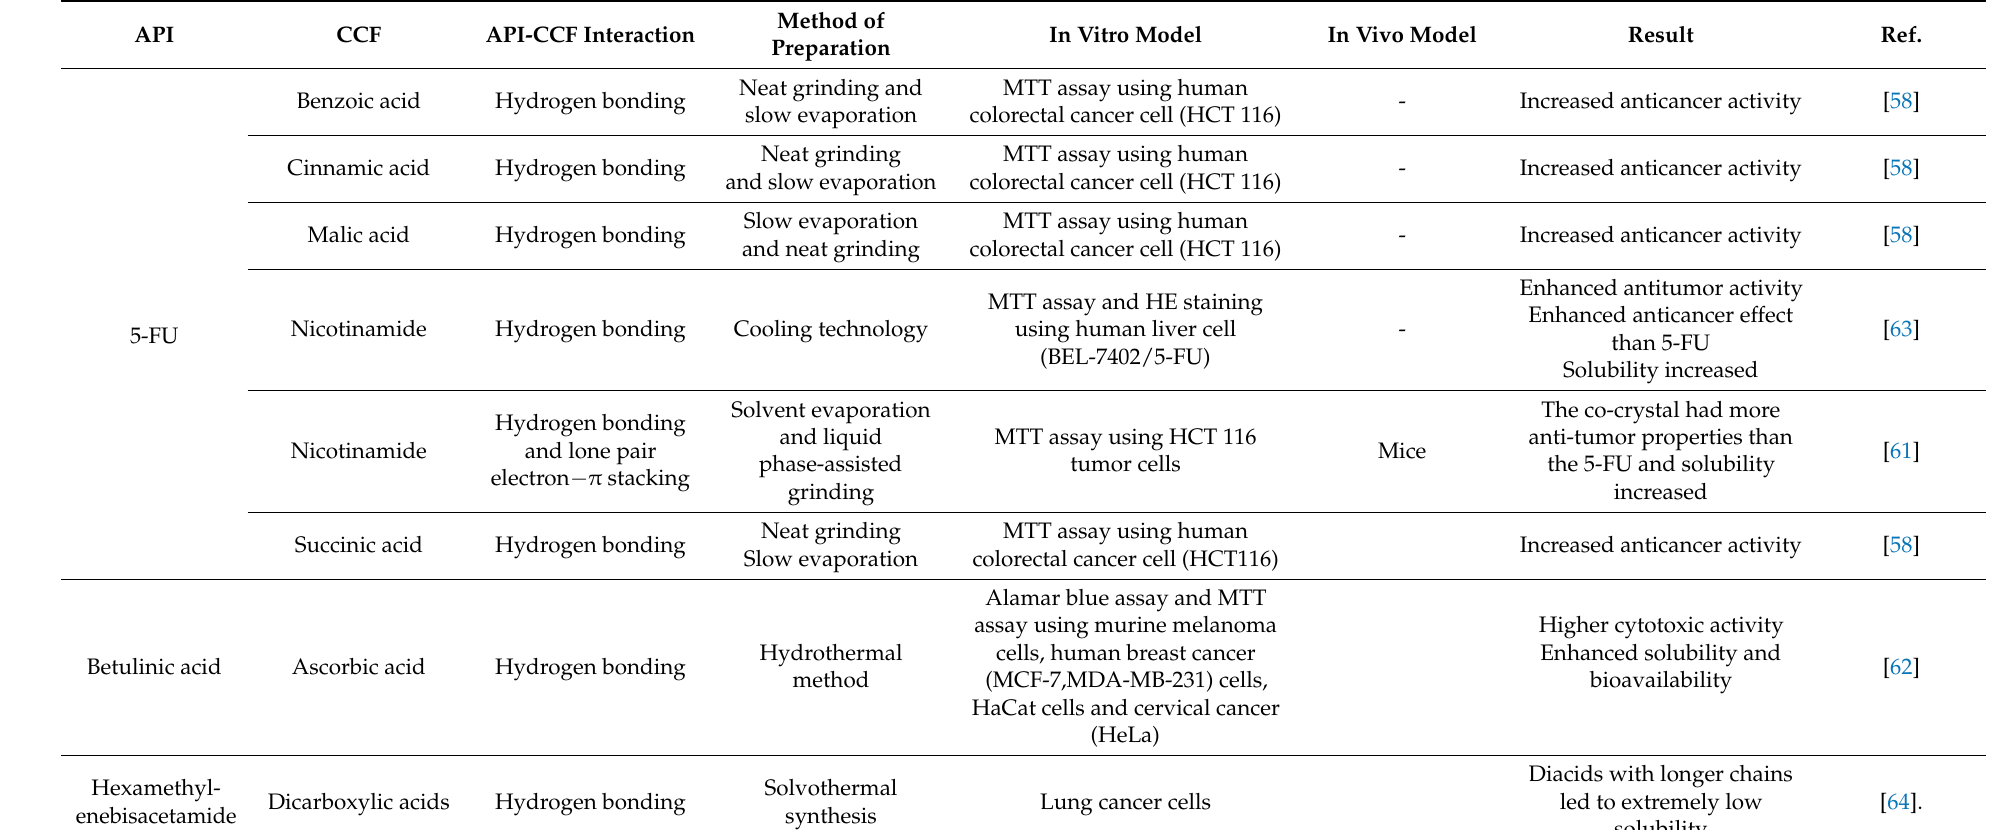
Table 2. A summary of findings derived from co-crystal studies in the treatment of neoplastic